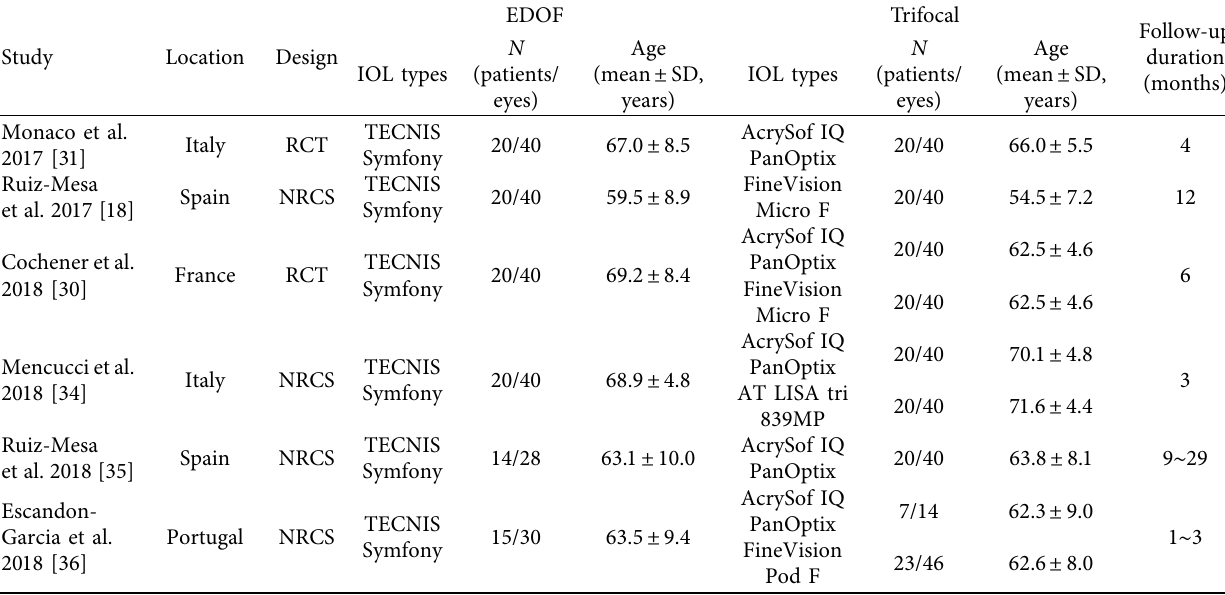
Figure 1: The flow diagram of identification and inclusion of the eligible studies based on the Preferred Reporting Items for Systematic Reviews and Meta-analyses flowchart. Table 1: Characteristics of the included studies ( n �